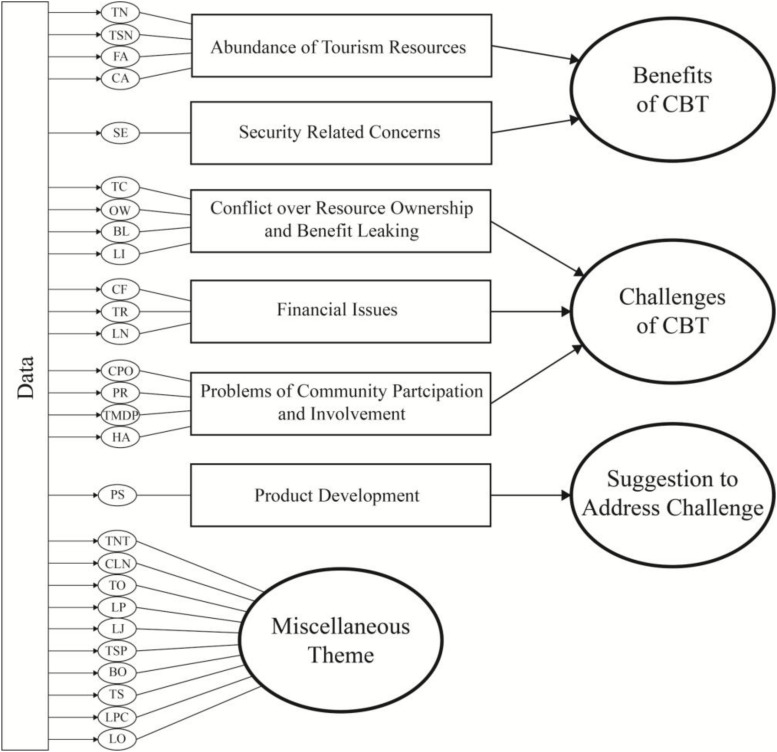
Thematic network.